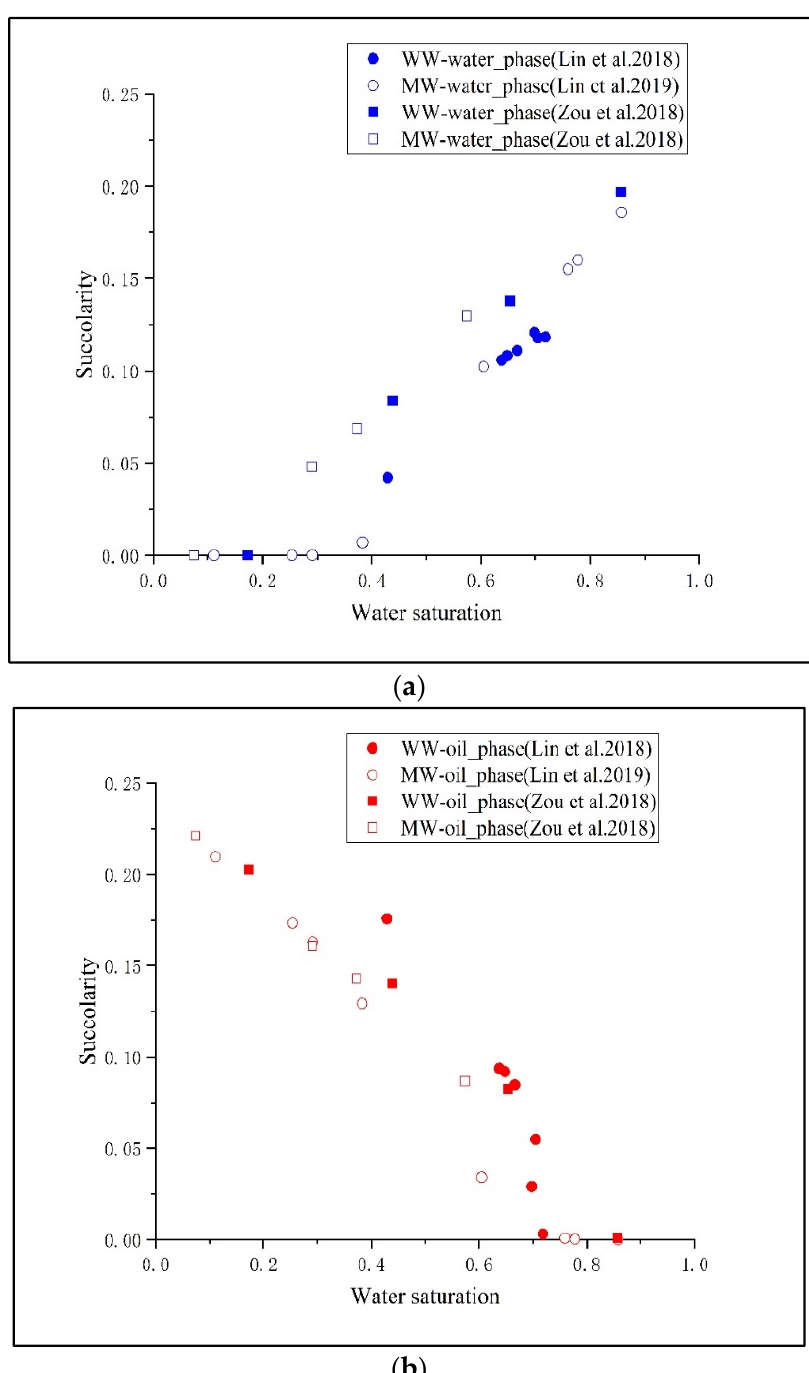
Figure 5. Comparison of succolarity results along flow direction for water phase ( a ) and oil phase ( b ) in water-wet and mixed-wet cases.